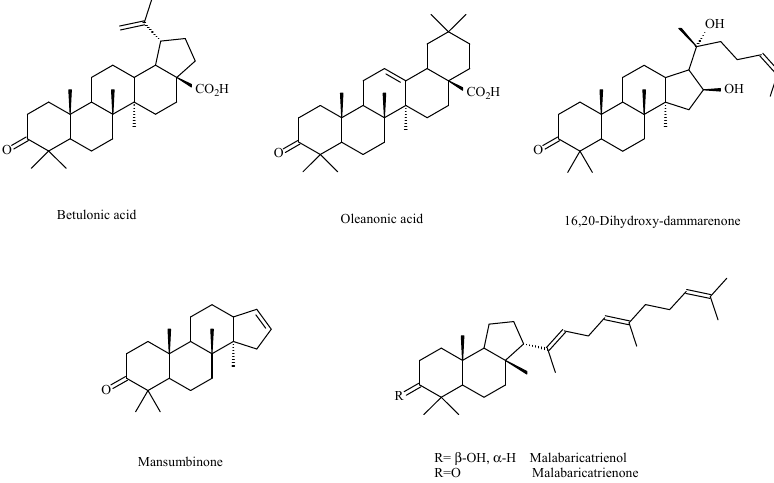
Figure 2. Triterpenoidic compounds isolated from B. microphylla [31].